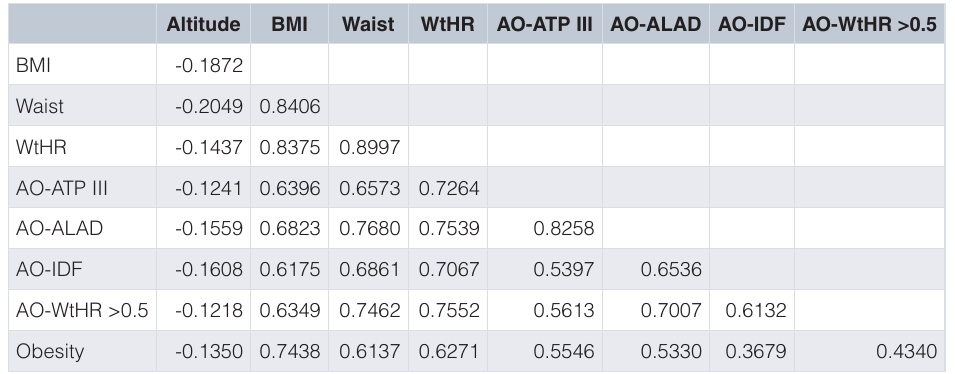
Table 3. Correlation between altitude and each of our parameters of interest.